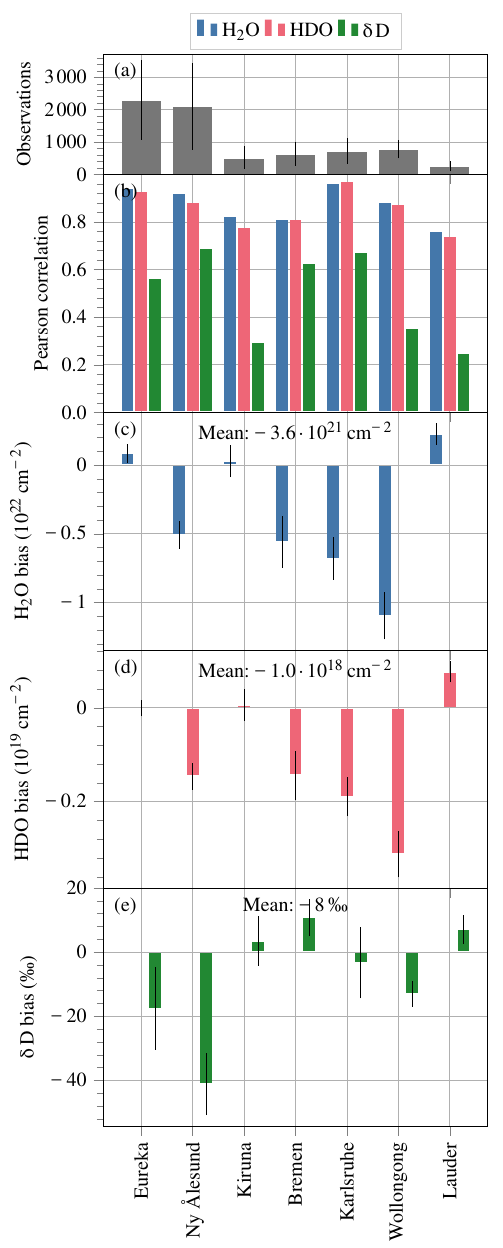
Figure 5. Statistics for the validation of the non-scattering re- trievals: (a) average number of measurements per month and their standard deviation. (b) Pearson correlation coefficient between MU- SICA and SCIAMACHY monthly averages of H 2 O (blue), HDO (red) and δ D (green). (c) Bias of H 2 O and its standard error. (d) Bias of HDO and its standard error. (e) Bias of δ D and its standard error.